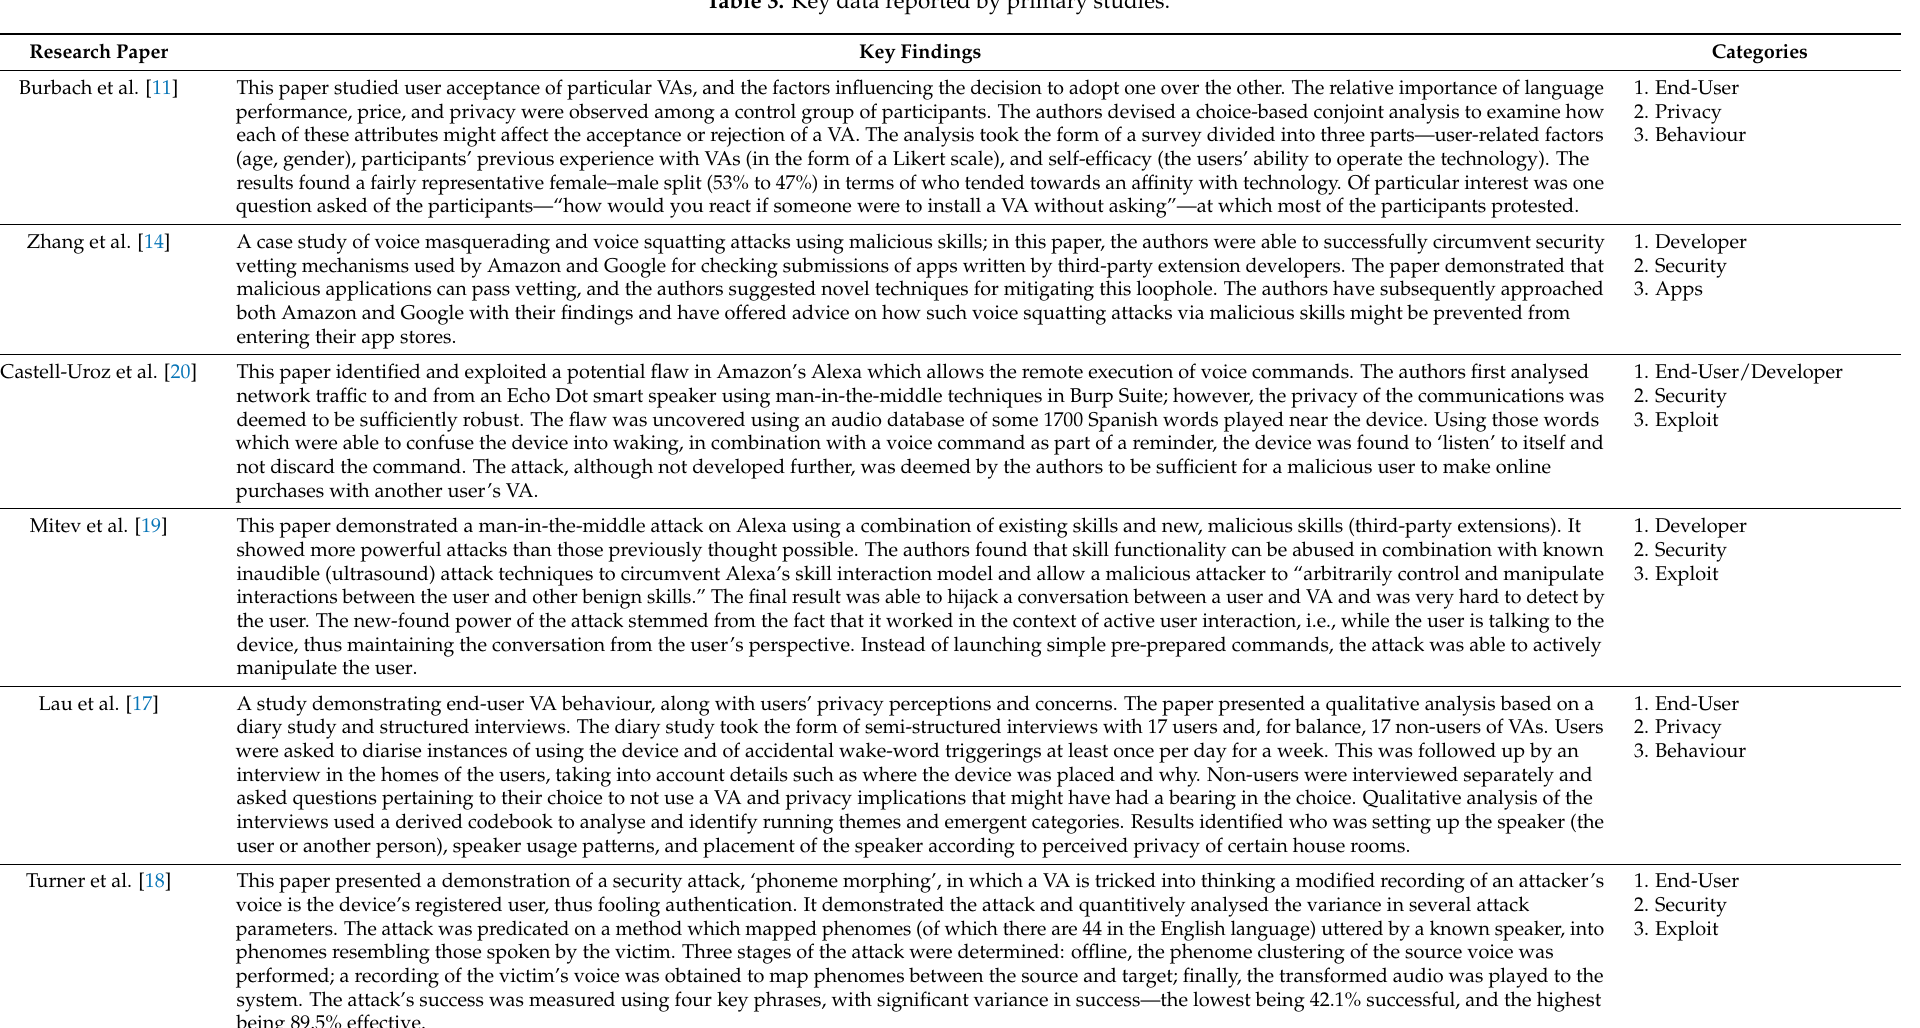
Table 3. Key data reported by primary